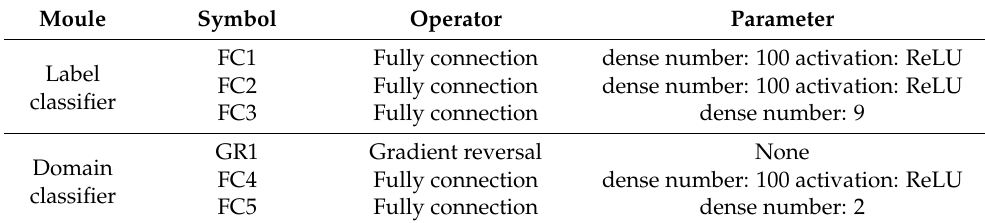
Table 1. Cont. Moule Symbol